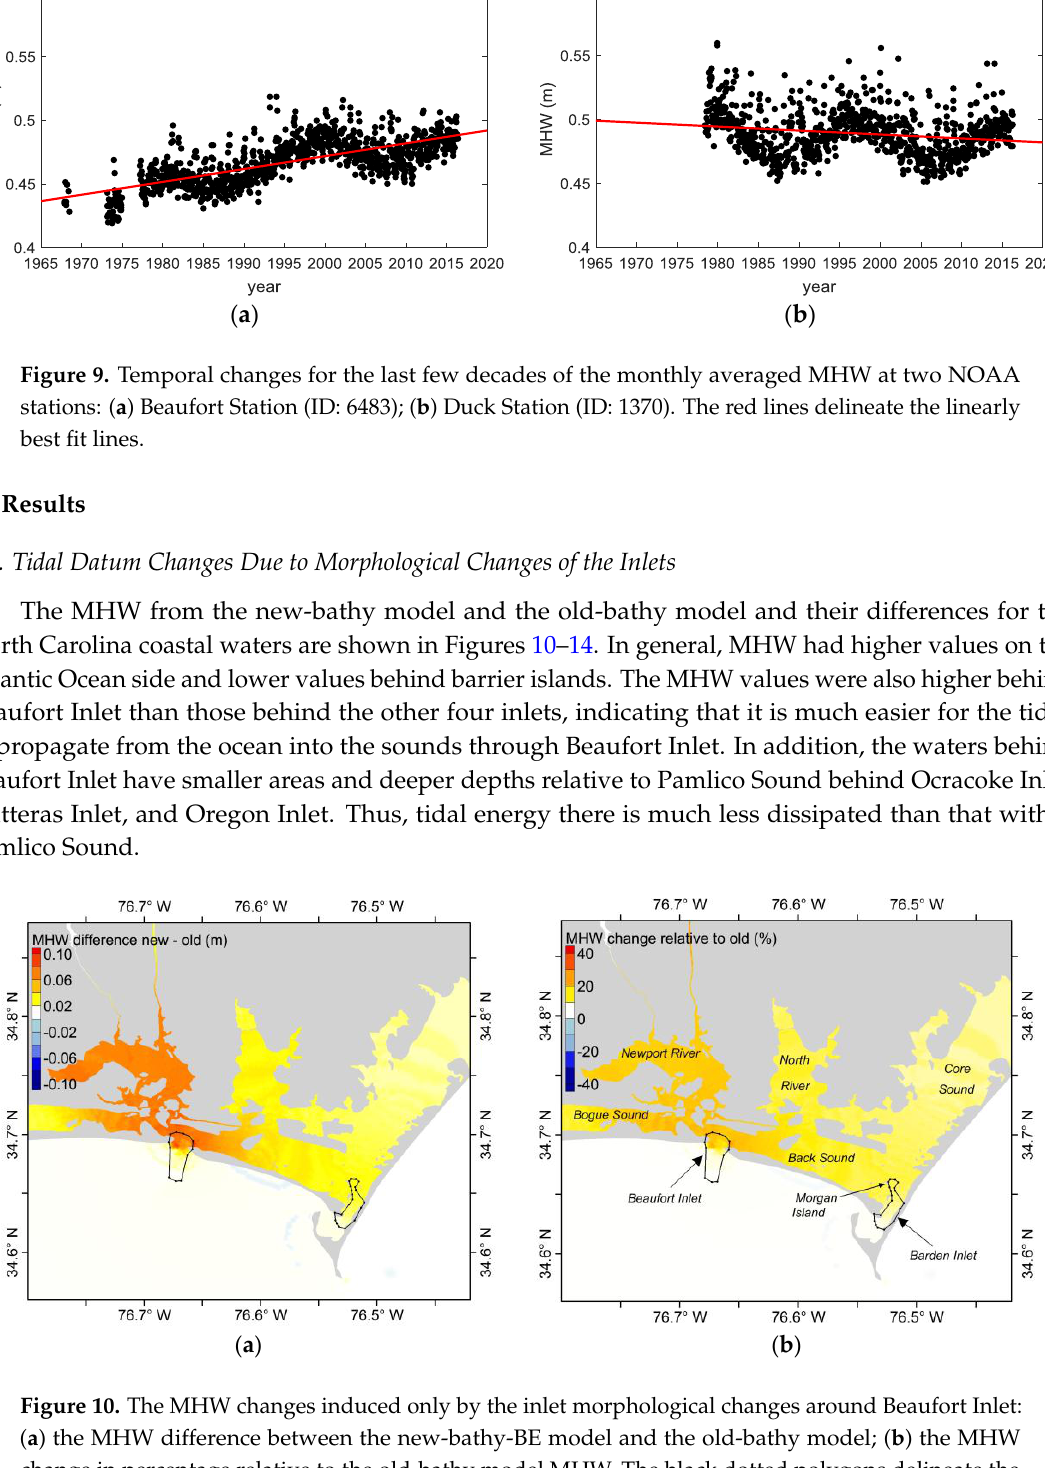
( b ) Figure 11. The MHW changes induced only by the inlet morphological changes around Barden Inlet: ( a ) the MHW difference between the new-bathy-BA model and the old-bathy model; ( b ) the MHW change in percentage relative to the old-bathy model MHW. The black dotted polygons delineate the area with changed bathymetry.